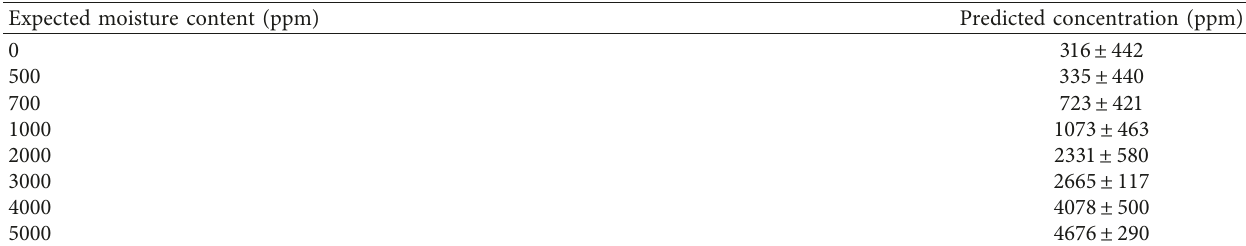
Table 3: Self-prediction of the calibration samples (lubricating oil).